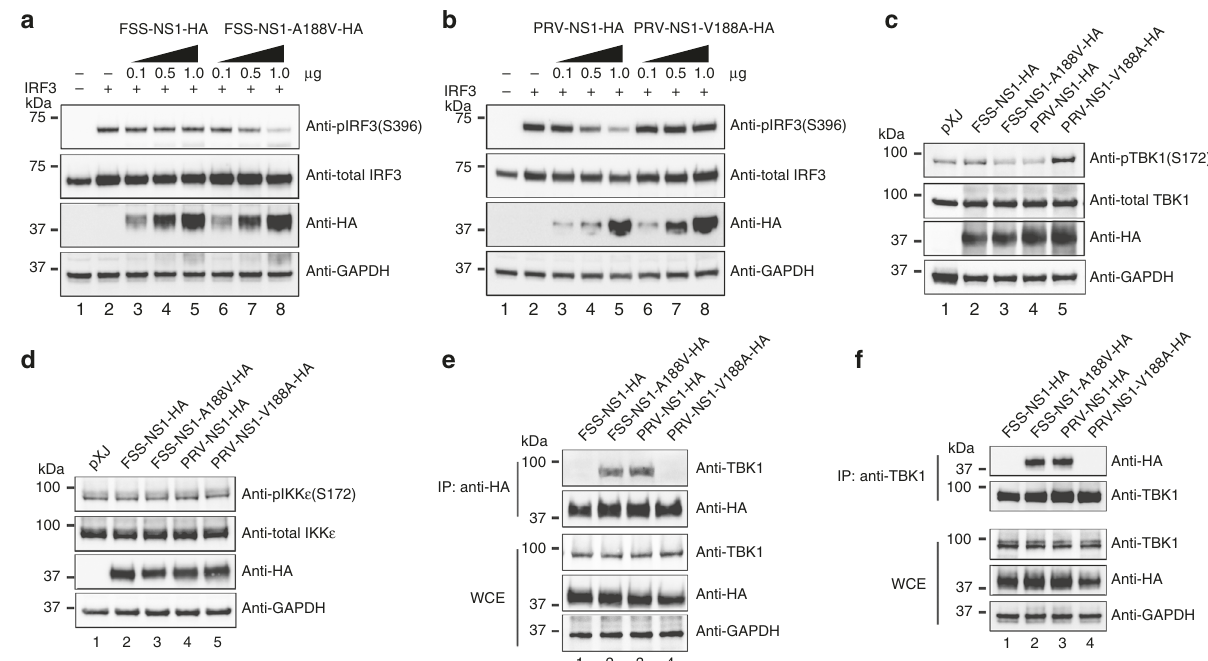
Fig. 4 NS1 with 188-Val antagonizes IFN- β production through targeting TBK1. a , b HEK-293T cells were co-transfected with IRF3-expressing plasmid, RIG-I (2CARD)-encoding plasmid as a stimulator, FSS WT NS1-expressing plasmid or FSS NS1 A188V-expressing plasmid ( a ), PRV WT NS1-expressing plasmid or PRV NS1 V188A-expressing plasmid ( b ). At 24 h post-transfection, cells were harvested and lysed, and cell extracts were subjected to western blotting with indicated antibodies. c , d Plasmids expressing TBK1 ( c ) or IKK ε ( d ), together with FSS13025 WT, FSS13025 A188V, PRVABC-59 WT, or PRVABC-59 V188A expression plasmids were co-transfected into HEK-293T cells. Cells were harvested at 24 h post-transfection and analyzed by western blotting for pTBK1 (anti-pTBK1 S172), total TBK1 (anti-TBK1), pIKK ε (anti-pIKK ε S172), total IKK ε (anti-IKK ε ), GAPDH (anti-GAPDH), and NS1 protein (anti-HA). e , f Co-immunoprecipitation for detection of NS1 and TBK1 interaction. HEK-293T cells were transfected with TBK1-encoding plasmid and HA-tagged FSS NS1, FSS NS1 A188V, PRV NS1, or PRV NS1 V188A expression plasmid. At 24 h post-transfection, cells were harvested and whole-cell extracts (WCE) were used for immunoprecipitation using anti-HA beads ( e ) or anti-TBK1 antibody ( f ), followed by immunoblot with indicated antibodies. The original uncropped